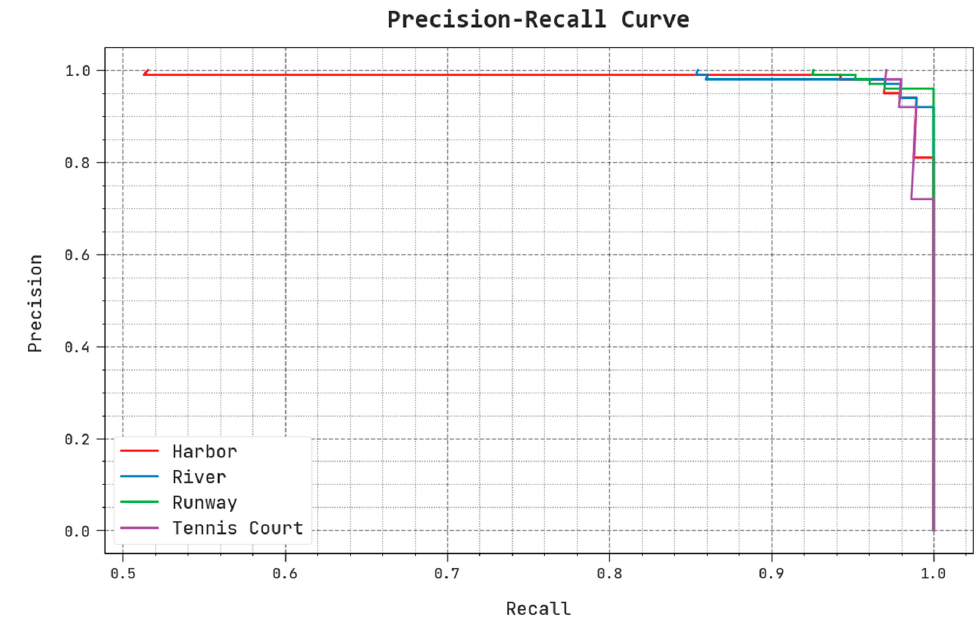
Figure 11. Precision–recall outcomes of the BSBE-PPODLC approach.